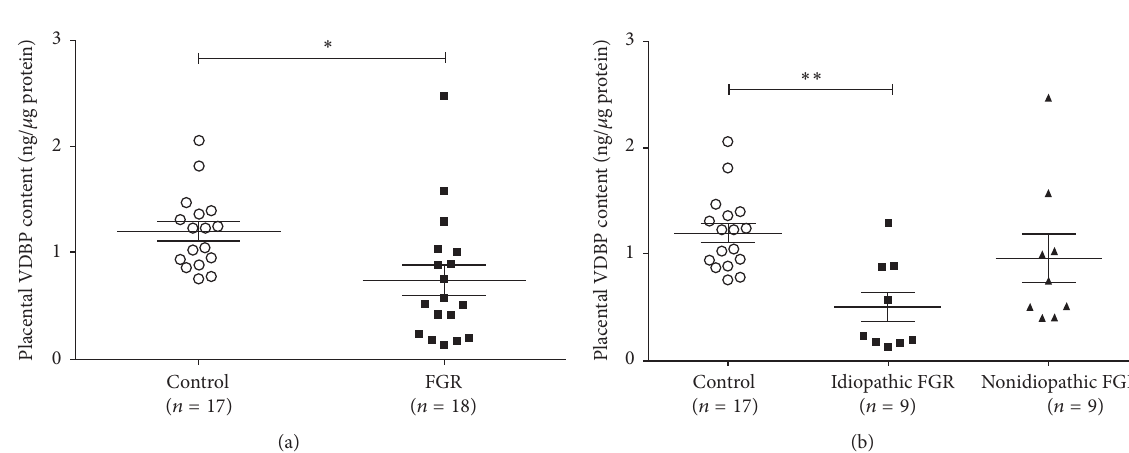
Figure 1: (a) Quantification of VDBP protein content in third-trimester placenta samples from control and FGR pregnancies. ∗ 𝑝 < 0.05 , unpaired Student’s 𝑡 -test with Welch’s correction. (b) The same data shown in panel (a) but with data from FGR pregnancies separated into idiopathic and nonidiopathic FGR ∗∗ 𝑝 < 0.01 , Kruskal-Wallis test with Dunn’s multiple comparisons. Data presented as mean ±